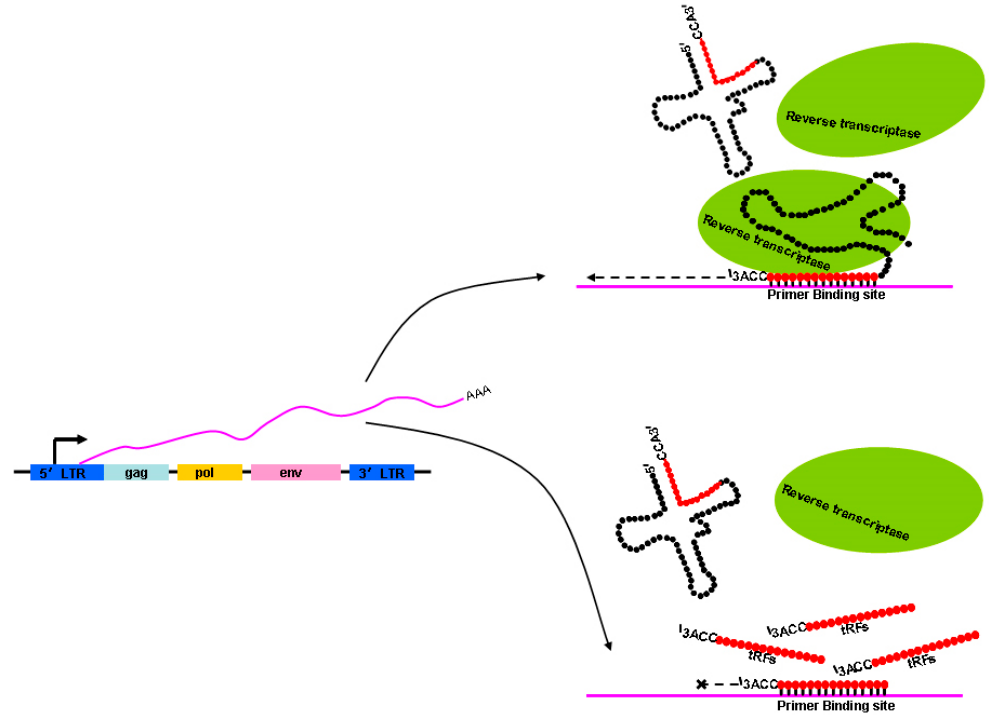
Figure 3. Schematic illustration showing how the reverse transcription processes of endogenous retrovirus (ERV) transcripts are repressed. The ERV genes env , gag , and pol are flanked by LTRs that regulate ERV transcription. The 3 ′ terminus of intact mature tRNA is used as the special primer to complete the reverse transcription process. However, the process is interrupted when 18-nt 3 ′ -tRF (tRNA-derived fragment) binds to the primer binding site.